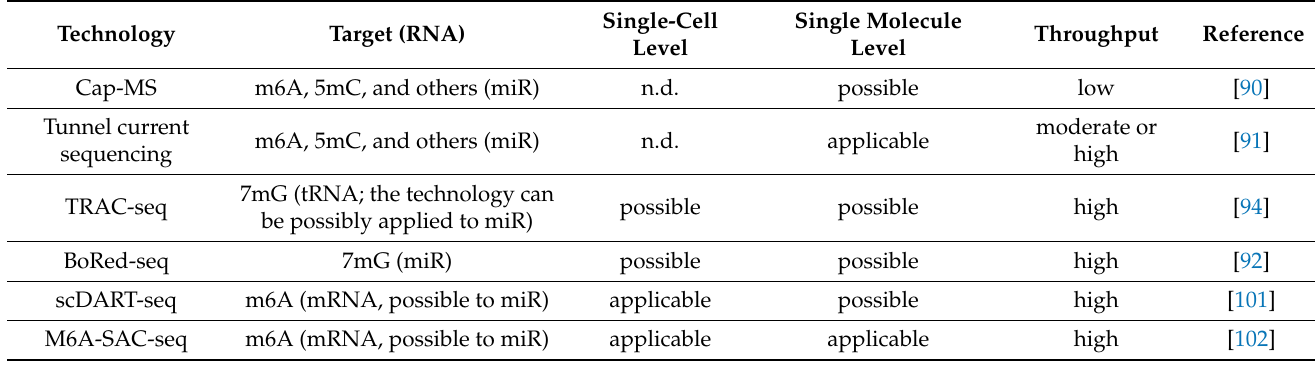
Table 1. Sequencing techniques for the investigation of episomiRs.